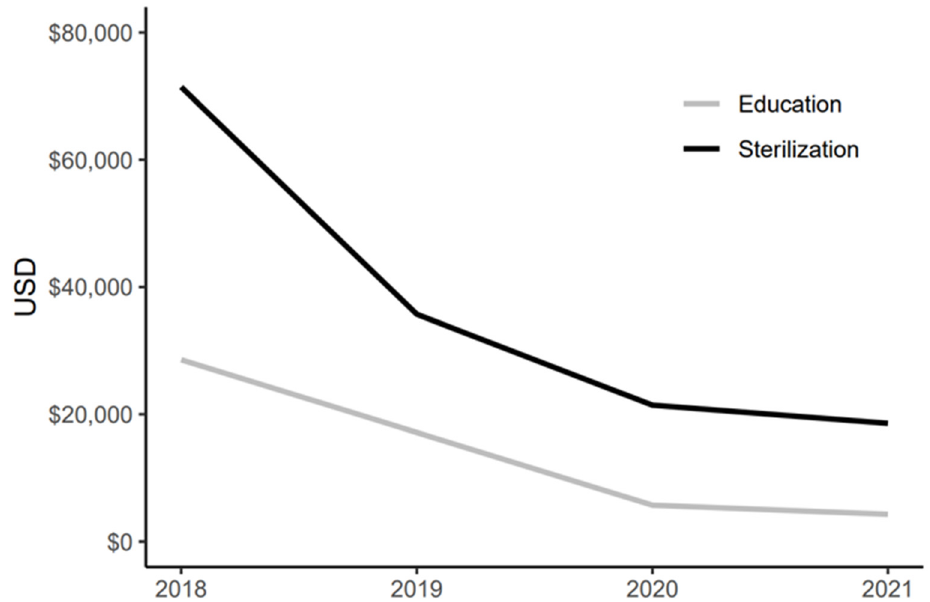
Figure 3. Maximum allowable amounts (CLP) that an organization could be awarded for steriliza- tion and education projects from 2018 to